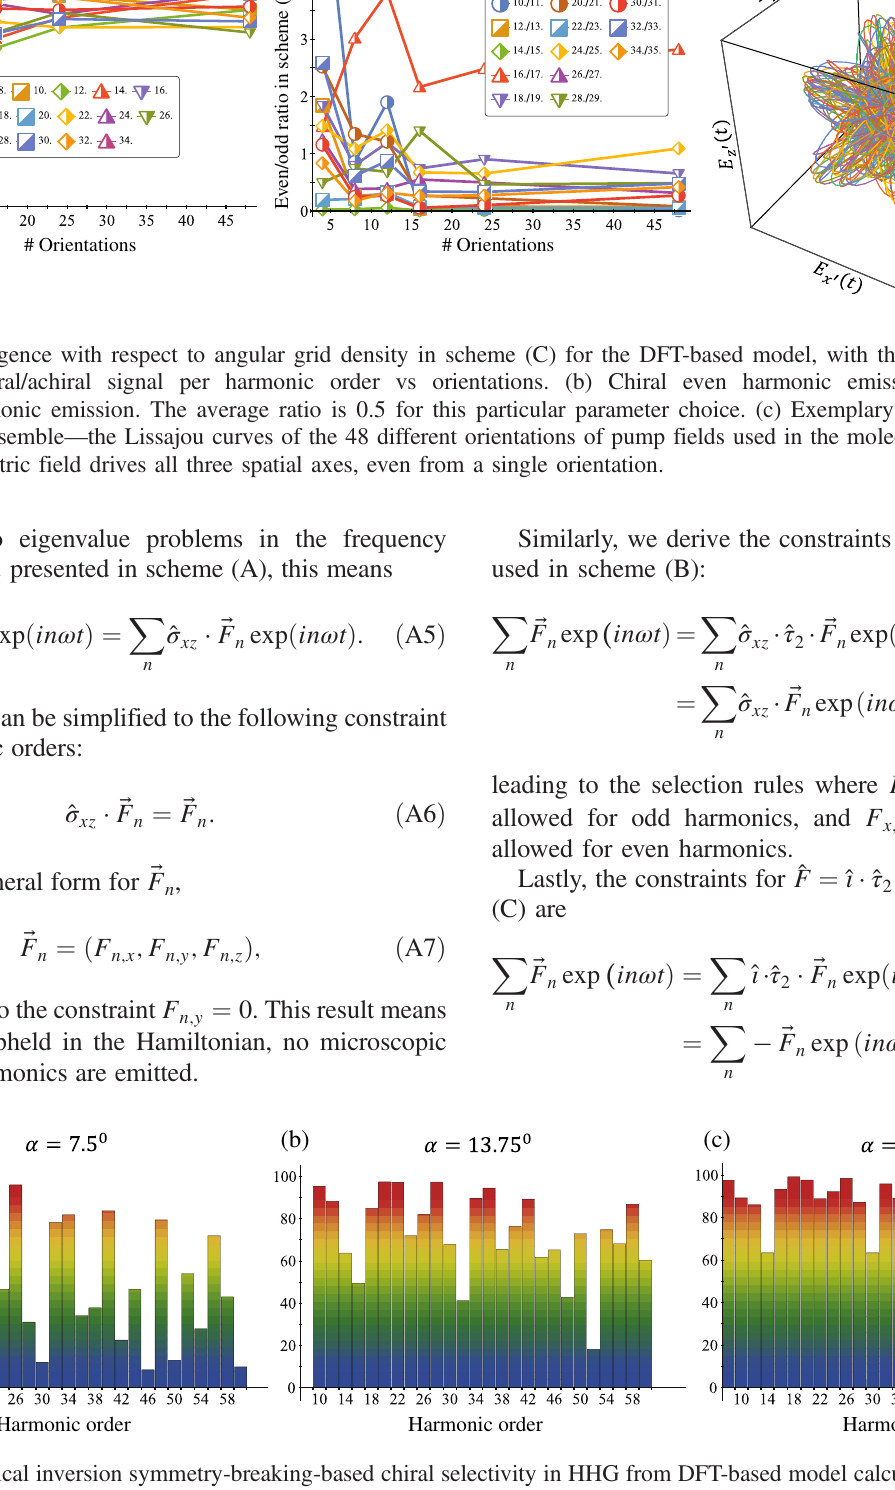
1 . 2 × 10 13 W = cm 2 , ϕ ¼ π = 2 , Δ ¼ 1 , ε 1 , ε 1 , for 1 ¼ 3 ¼ max ¼